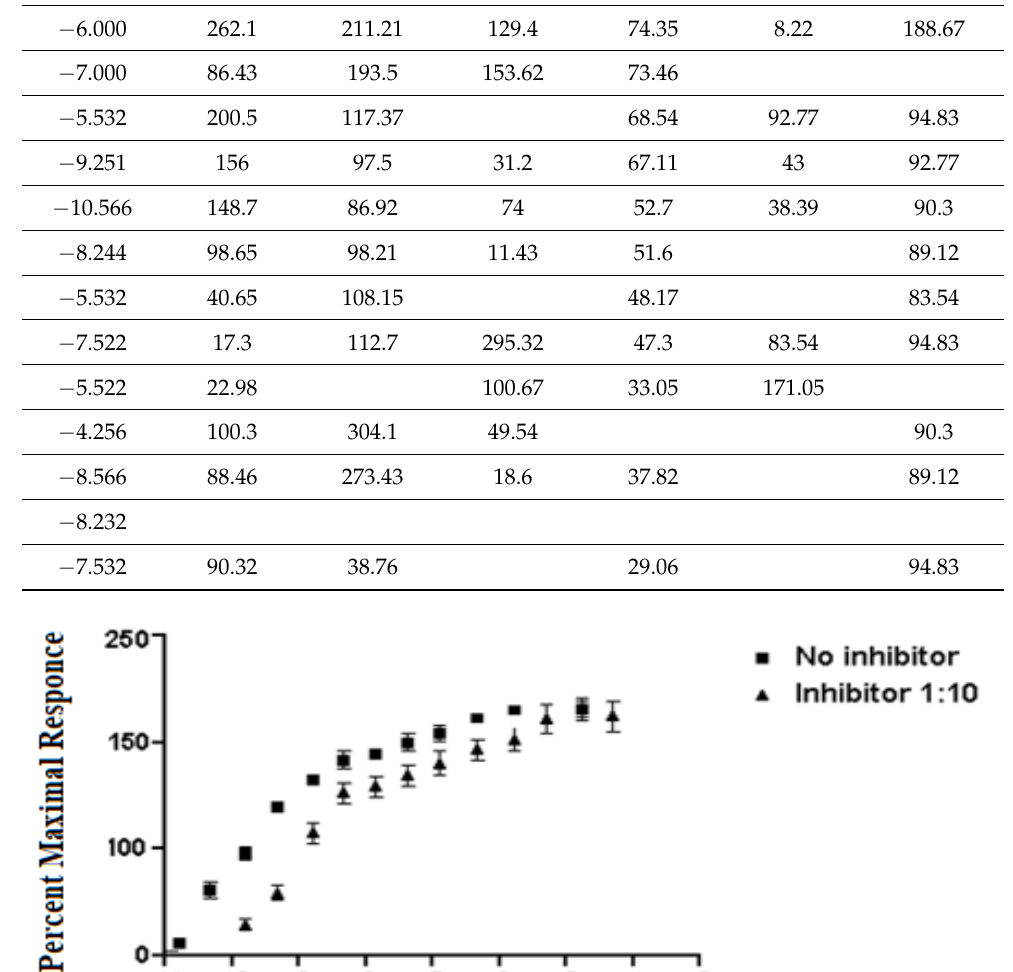
Figure 1. The inhibitory effect curve of P. amygdalus var . amara at various concentrations (5–300 µ